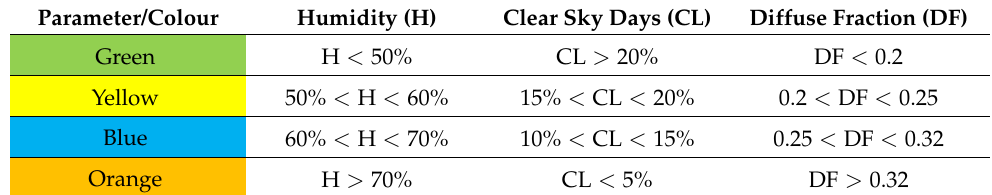
Table 3. The coding representing the different levels of clear sky days, diffuse fraction, and humidity. Parameter/Colour Humidity (H) Clear Sky Days (CL) Diffuse Fraction (DF) Green H < 50% CL > 20% DF < 0.2 Yellow 50% < H < 60% 15% < CL < 20% 0.2 < DF < 0.25 Blue 60% < H < 70% 10% < CL < 15% 0.25 < DF < 0.32 Orange H > 70% CL < 5% DF >